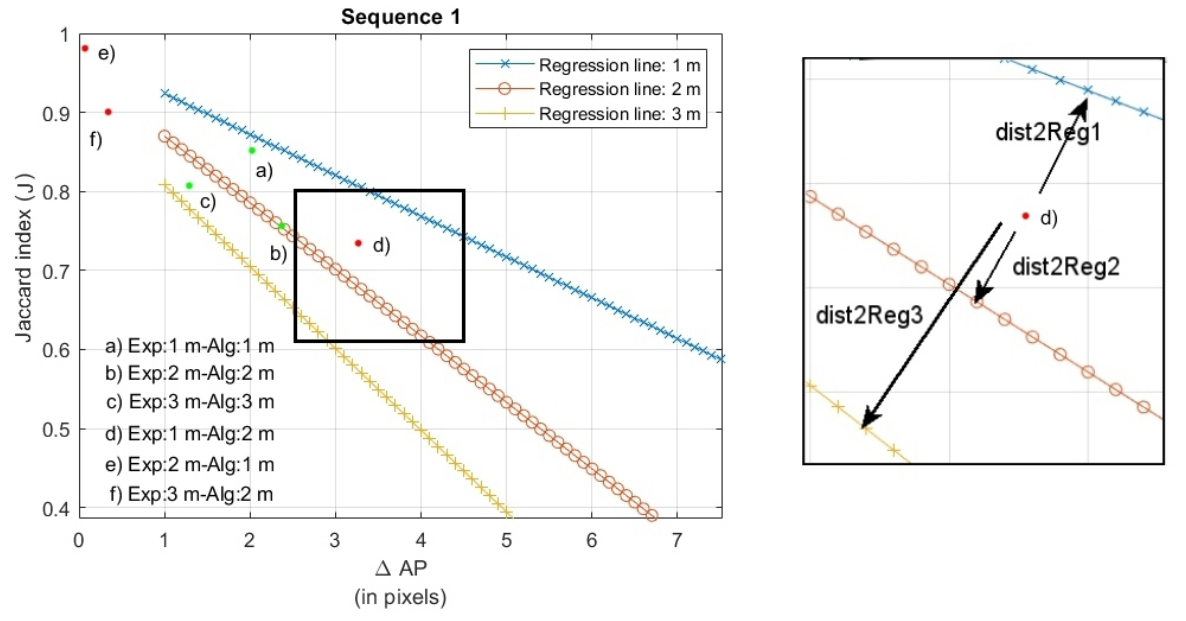
Figure 10. Sample results of algorithm operation—expert and algorithm response—cases from Figure